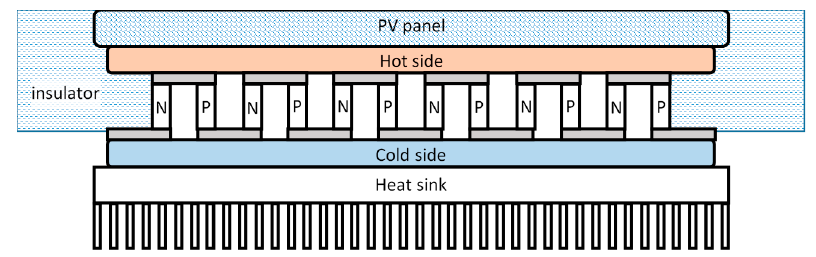
Figure 2. PV–thermoelectric generator (PV-TEG) structure.